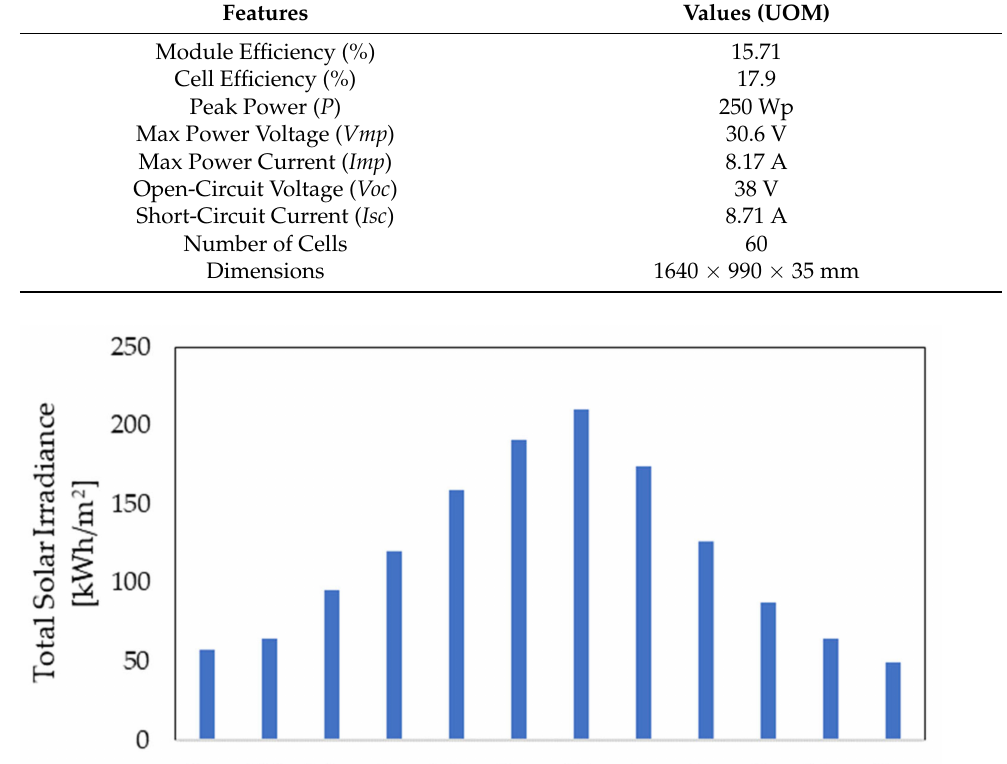
Figure 5. Monthly solar